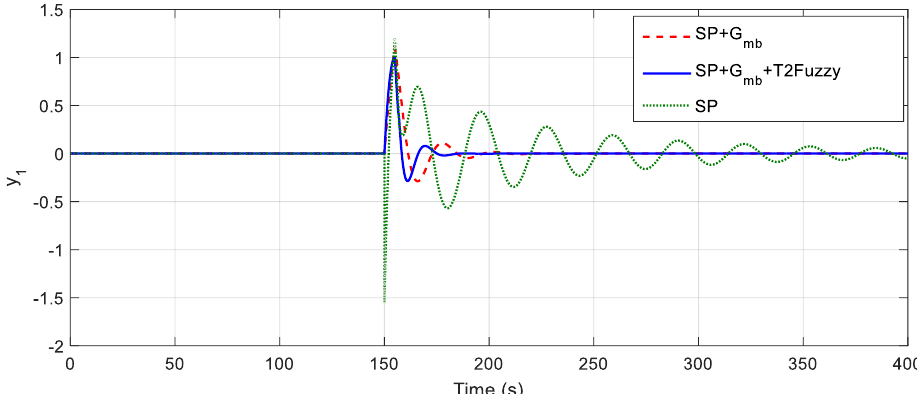
Figure 11. Performance of three control methods for 𝑦 1 by applying disturbance.